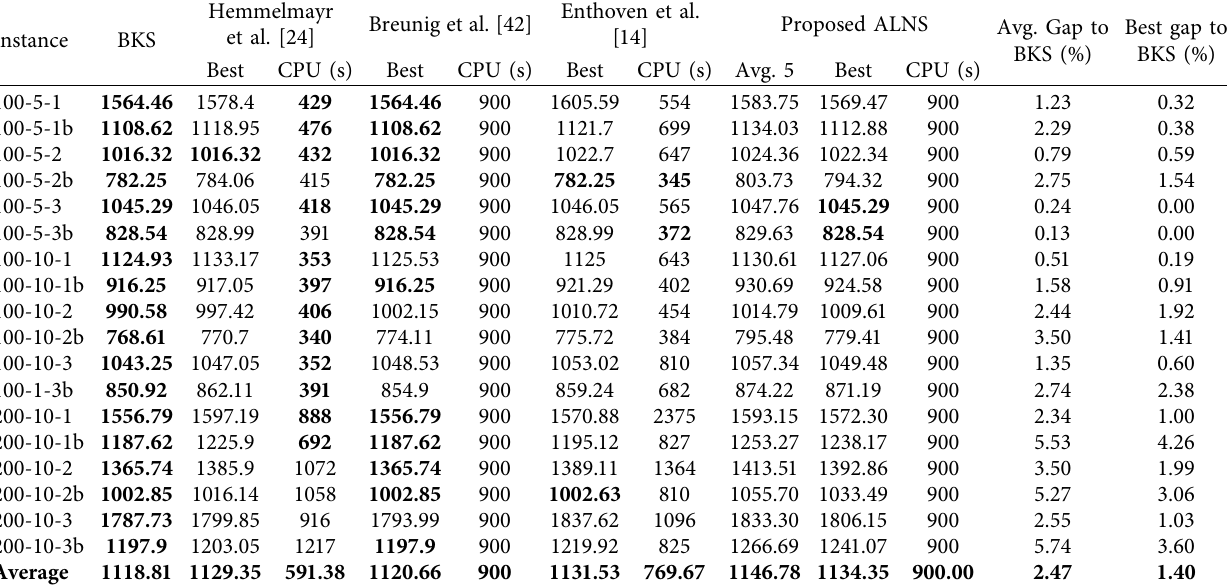
Table 5: Comparative results for solving 2EVRP Set 5